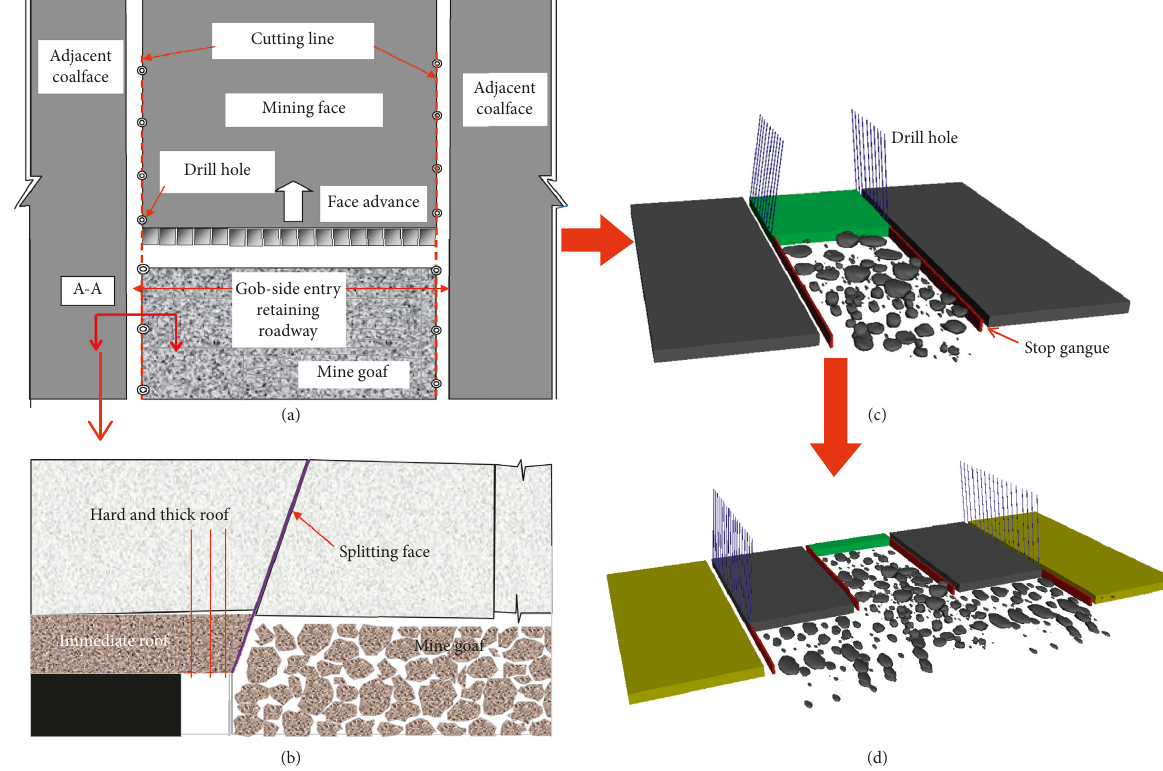
Figure 1: Schematic diagram of GERPOHR technology. (a) Technical schematic diagram. (b) Profile design. (c) Three-dimensional view. (d) Layout of the working face.